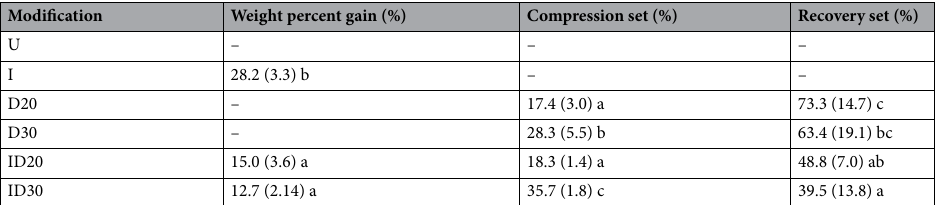
Table 4. Weight percent gain, compression set, and recovery set values of modified inner part of oil palm trunk. Notes: Values in parentheses are standard deviations. U = Untreated; I = Impregnation; D20 and D30 = densification with compression ratio (CR) 20% and 30%, respectively; ID20 and ID 30 = compregnation with CR 20% and 30%, respectively. Different letters in the same column indicate significant differences at 5% level of significance, based on Duncan’s multiple range test.